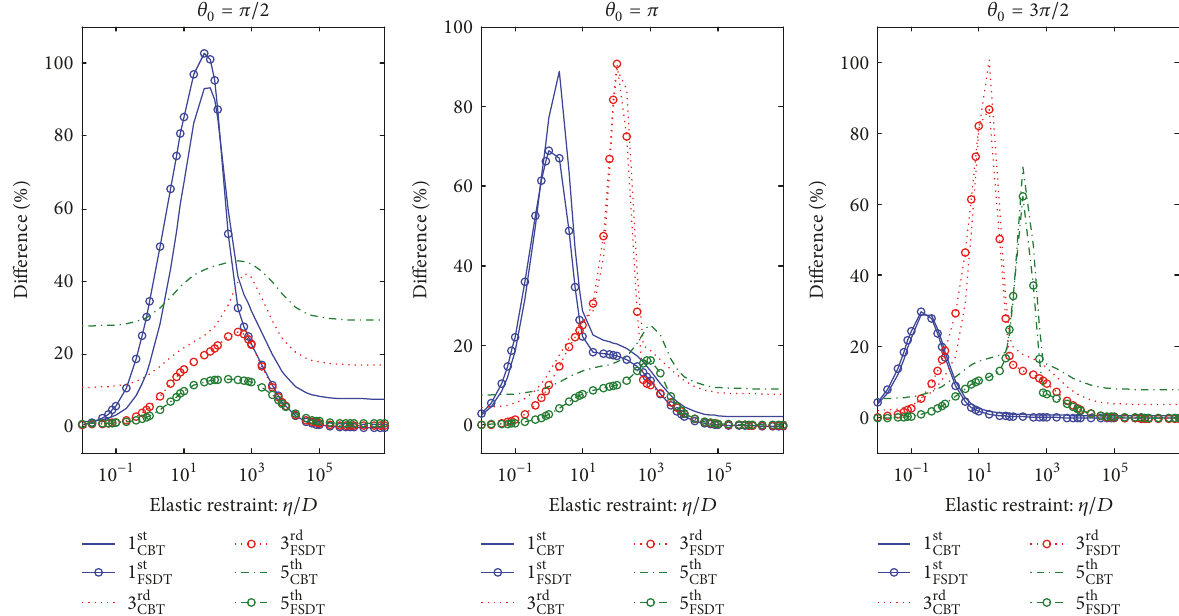
Figure 12: Relative deviations between frequency parameters Ω based on the CBT/FSDT theory models to those of 2D theory for elastically restrained circular beams with different restraint rigidities ( 𝜃 = 𝜃 0 : clamped; 𝜃 = 𝜃 1 : 𝑘 1 𝑢 = 0 , 𝑘 1 𝑤 = 𝜂 ).